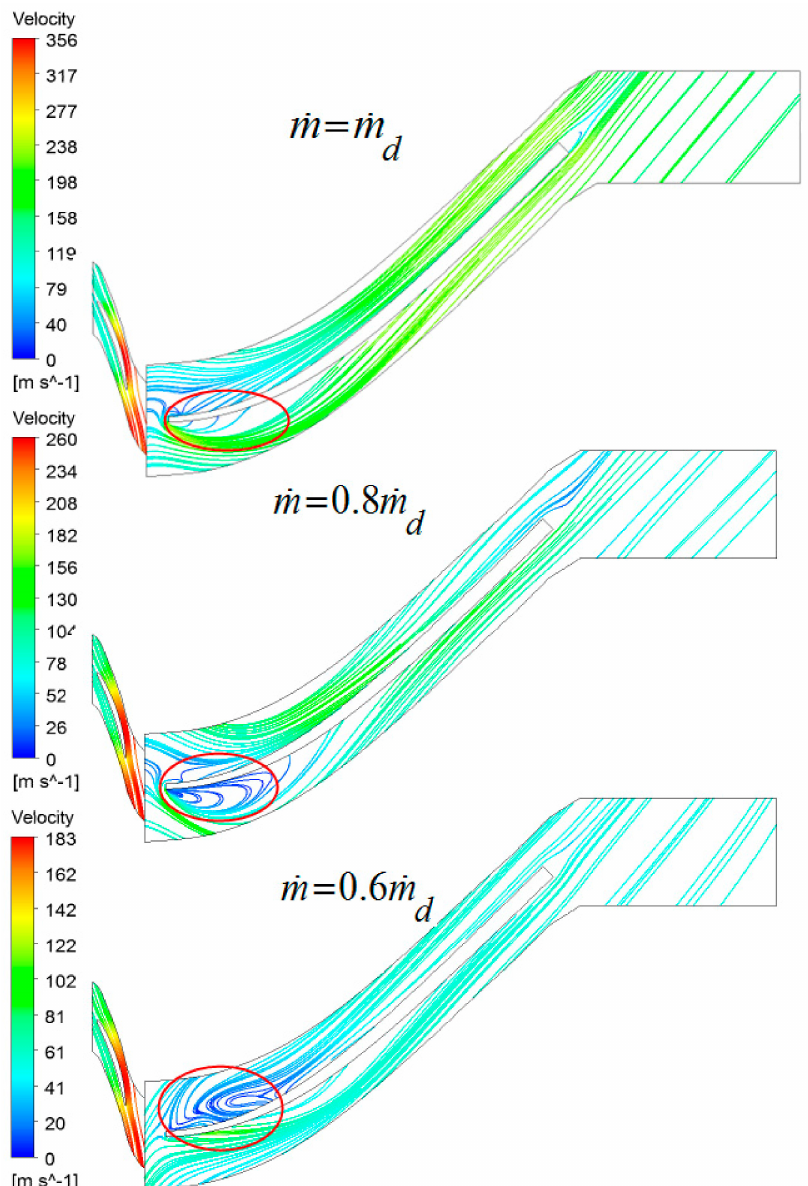
Figure 21. The streamline for different mass flow rate at mid